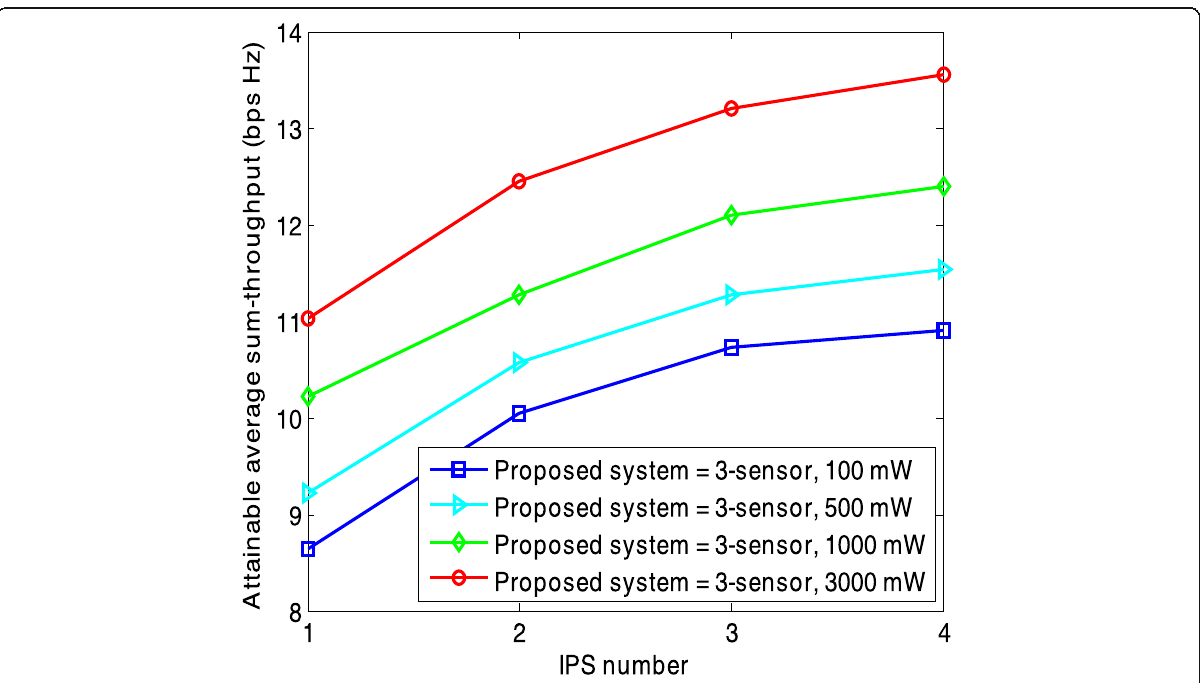
Fig. 9 Attainable average sum-throughput against transmission